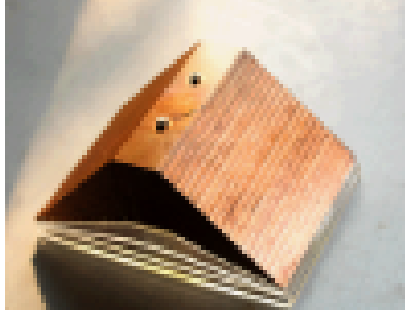
Figure 28. Experimental prototype of the carpet cloak [92].